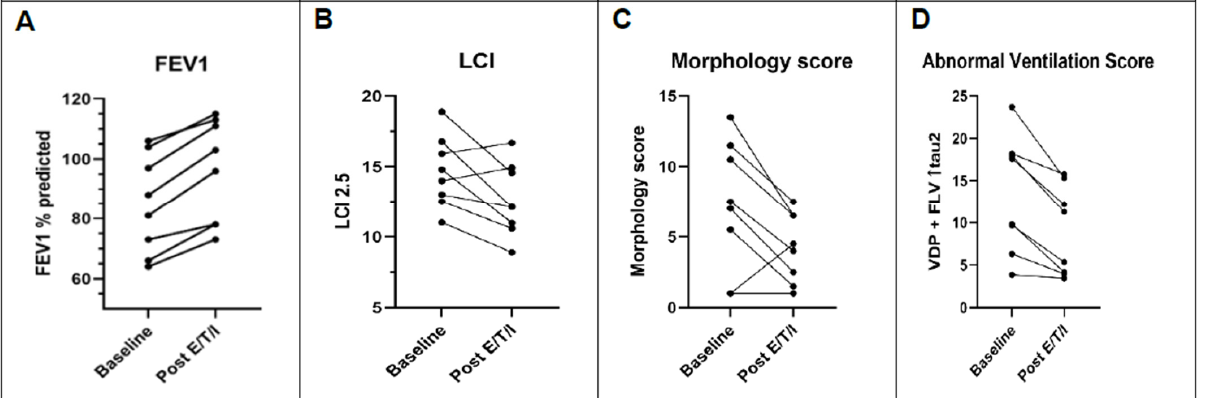
Figure 2. Effect of E/T/I on lung function, lung MRI morphology score, and lung MRI ventilation score in subjects with CF. Patient level changes from baseline to one month after elexacaftor/tezacaftor/ivacaftor. ( A ) FEV1. ( B ) LCI. ( C ) Morphology score from 1 H MRI. ( D ) Abnormal ventilation score from 19 F MRI, a summation of VDP and FLV ↑ tau2 values. E/T/I: elexacaftor/tezacaftor/ivacaftor. FEV 1 : forced expiratory volume in 1 s. LCI: lung clearance index.